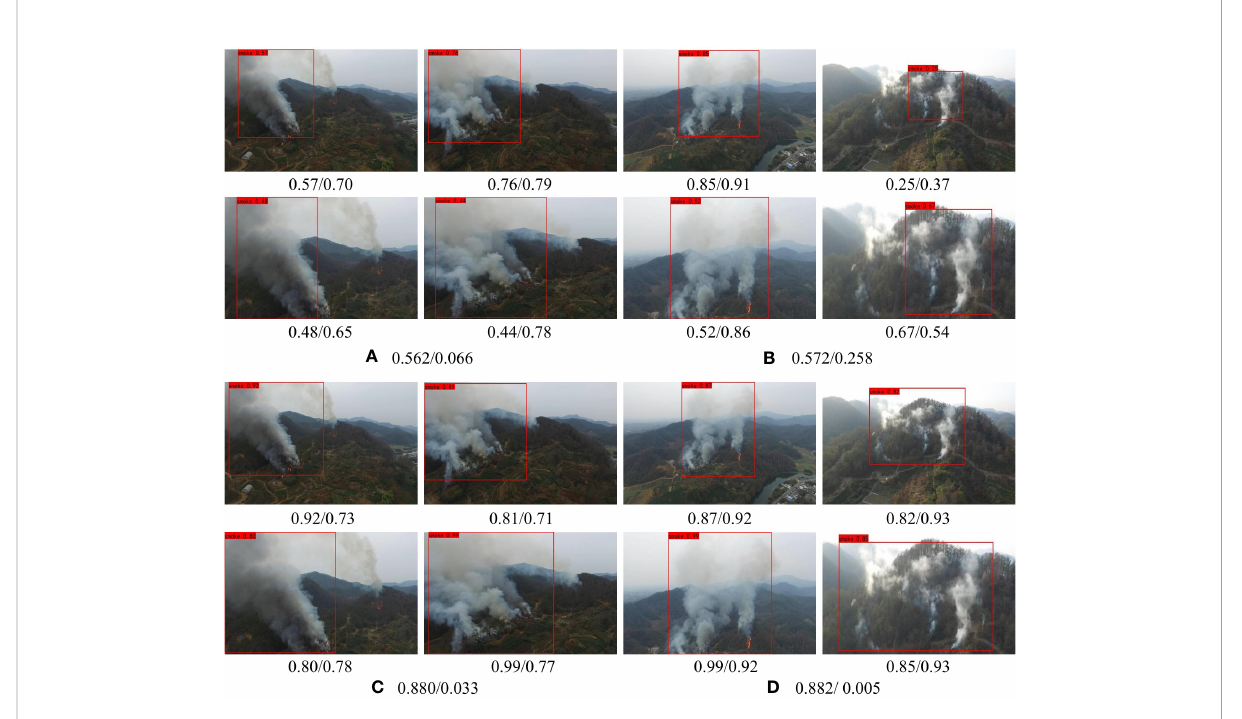
FIGURE 9 Ablation experiment on the adaptability of SAC to smoke with different size.